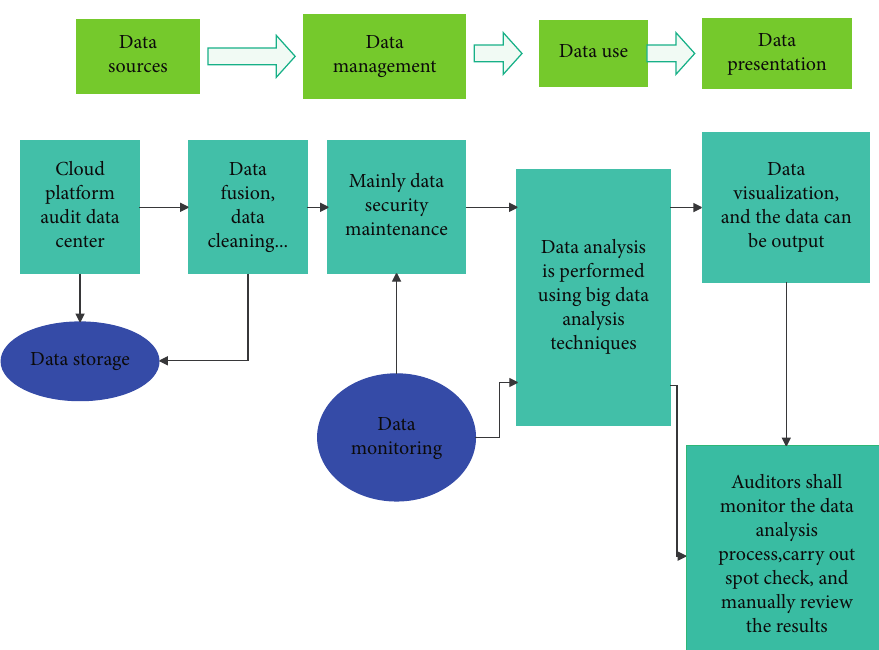
Figure 8: The flow of the data